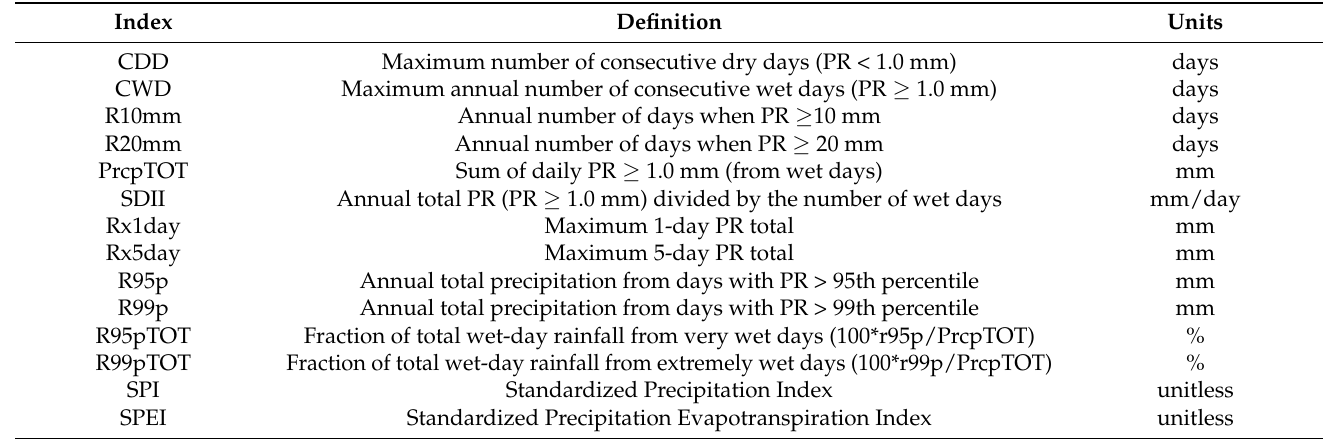
Table 1. The definitions and units of the climate extreme indices associated with extreme precipitation used in this